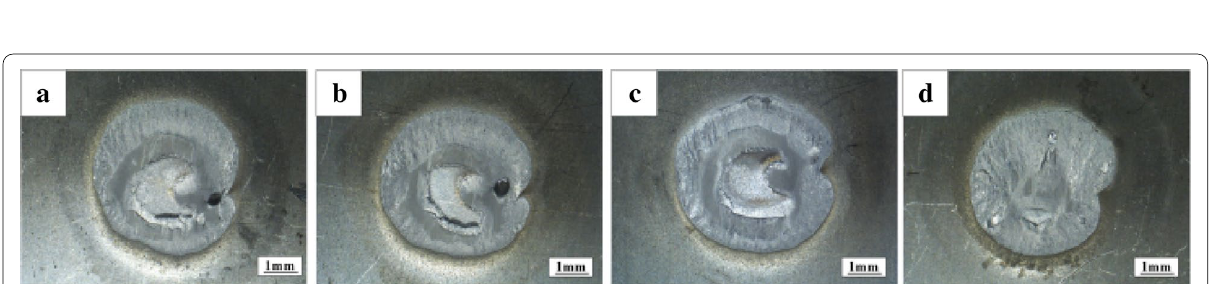
Figure 24 Tensile fracture morphology of welded joint under different welding methods: a 4-sections; b 5-sections; c 6-sections; d new 6-sections